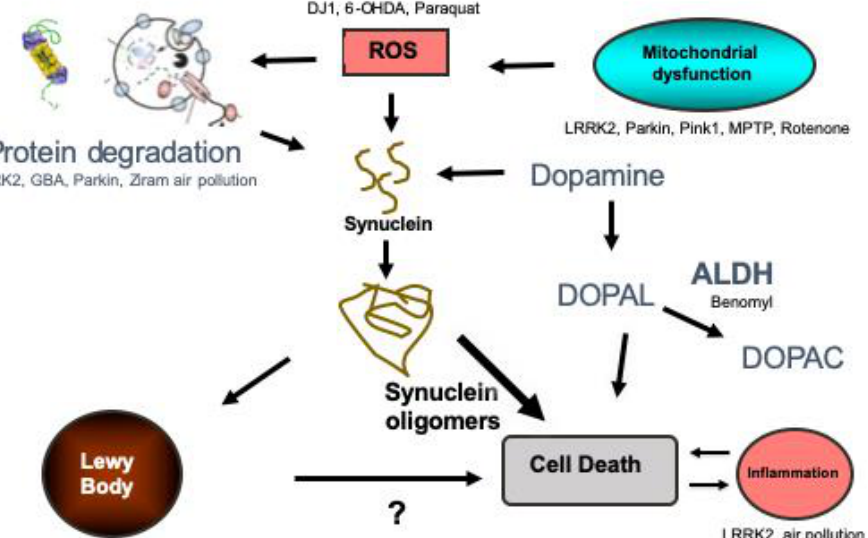
Figure 1. Summary of the proposed pathogenic pathways leading to Parkinson’s disease. The genes and toxins that have been studied in zebrafish are listed in the pathways that they likely influence. Protein degradation refers to autophagy and the ubiquitin proteasome system. ROS refers to reactive oxygen species. ALDH refers to aldehyde dehydrogenase. DOPAL refers to 3,4- Dihydroxyphenylacetaldehyde and DOPAC is 3,4-Dihydroxyphenylacetic acid.